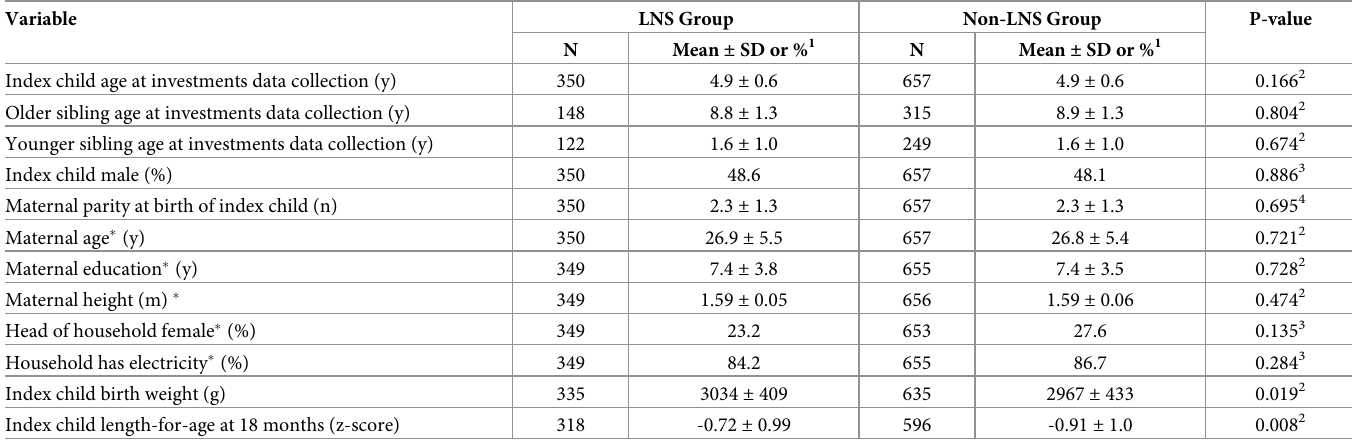
Table 2. Characteristics of follow-up sample by intervention